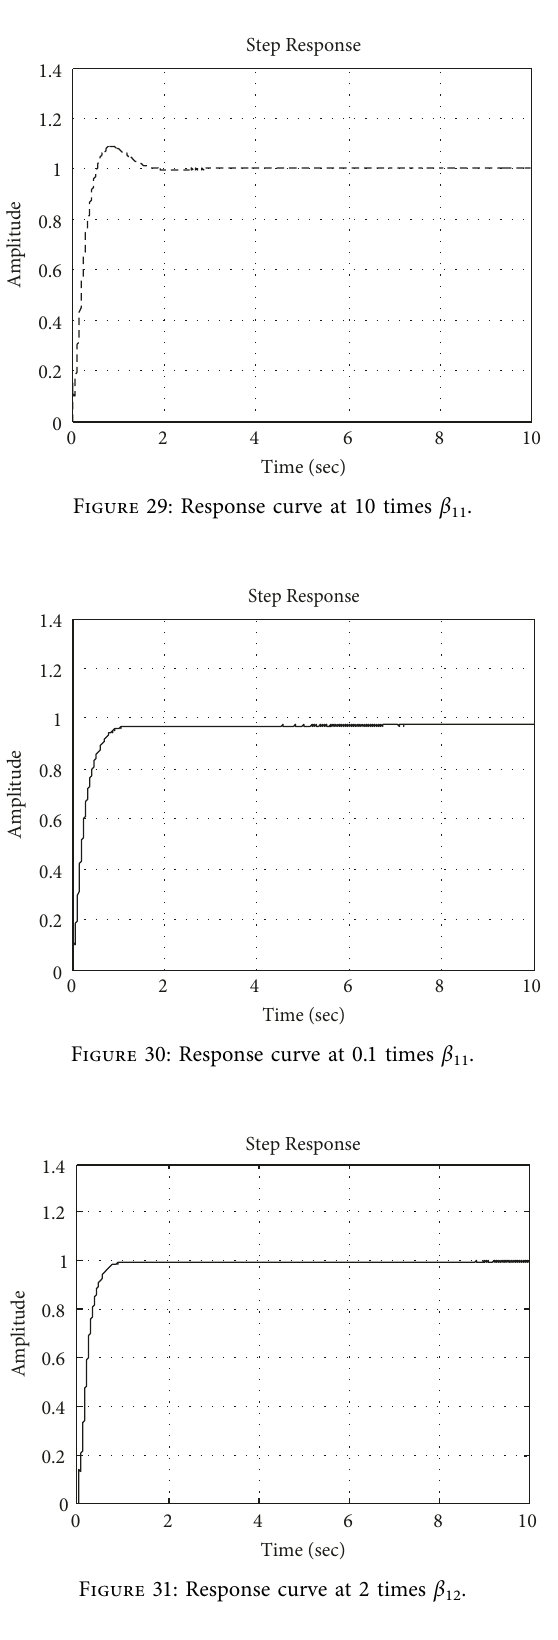
Figure 34: Response curve at 0.05 times β